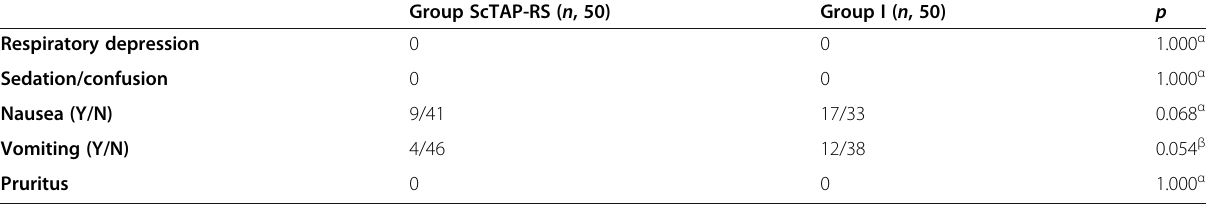
Table 4 The comparison of incidence of side effects between group ScTAP-RS and group I Group ScTAP-RS ( n , 50) Group I ( n , 50) Respiratory depression 0